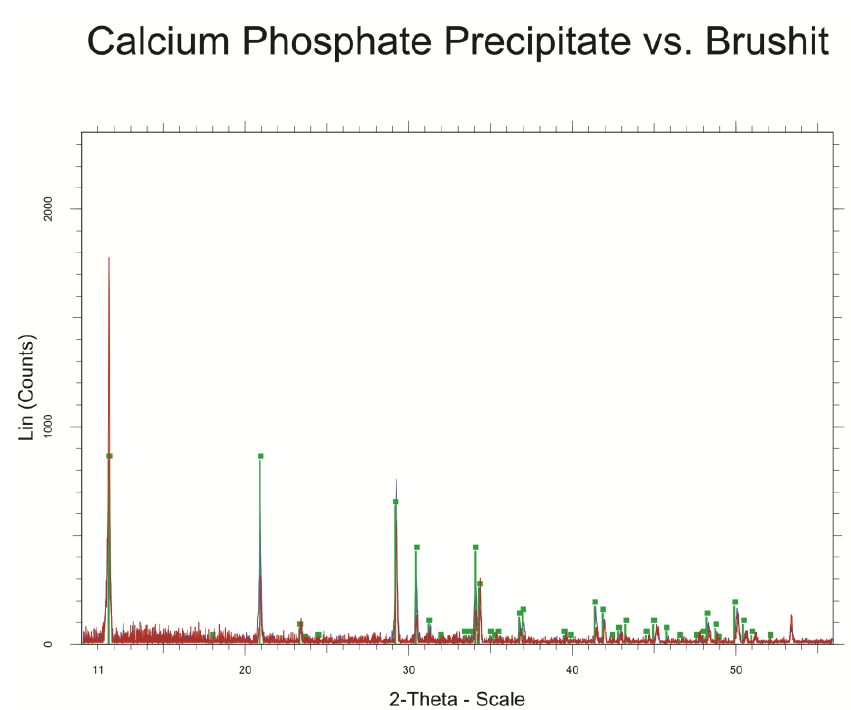
Figure 7. CaP precipitate phase identification as brushite via X-ray powder diffraction (XRD) [40]. Background and Kα -stripping were corrected. Red: CaP precipitate sample. Blue: comparison measurement of brushite (Carl Roth GmbH & Co. KG, Karlsruhe, Germany). Green: Brushite reference spectrum from the database of the International Center for Diffraction Data (ICDD).